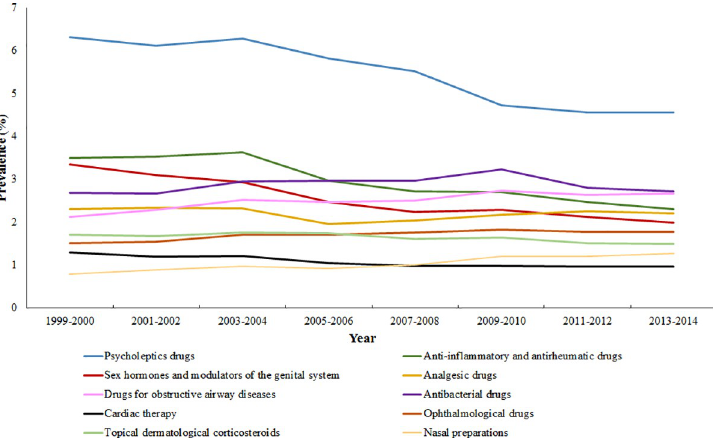
Fig 4. Prevalence of most commonly dispensed drug groups among adults in the Netherlands 1999–2014 (constant or downward trends).